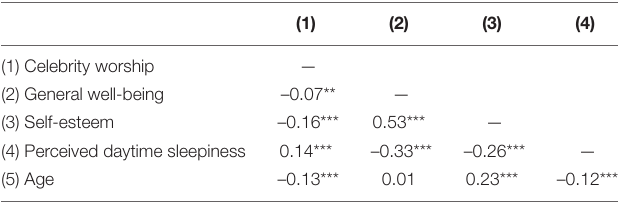
TABLE 4 | Partial correlations among celebrity worship, indicators of subjective well-being, and age, while controlling for gender and opposite/same-gender celebrity worship ( N =